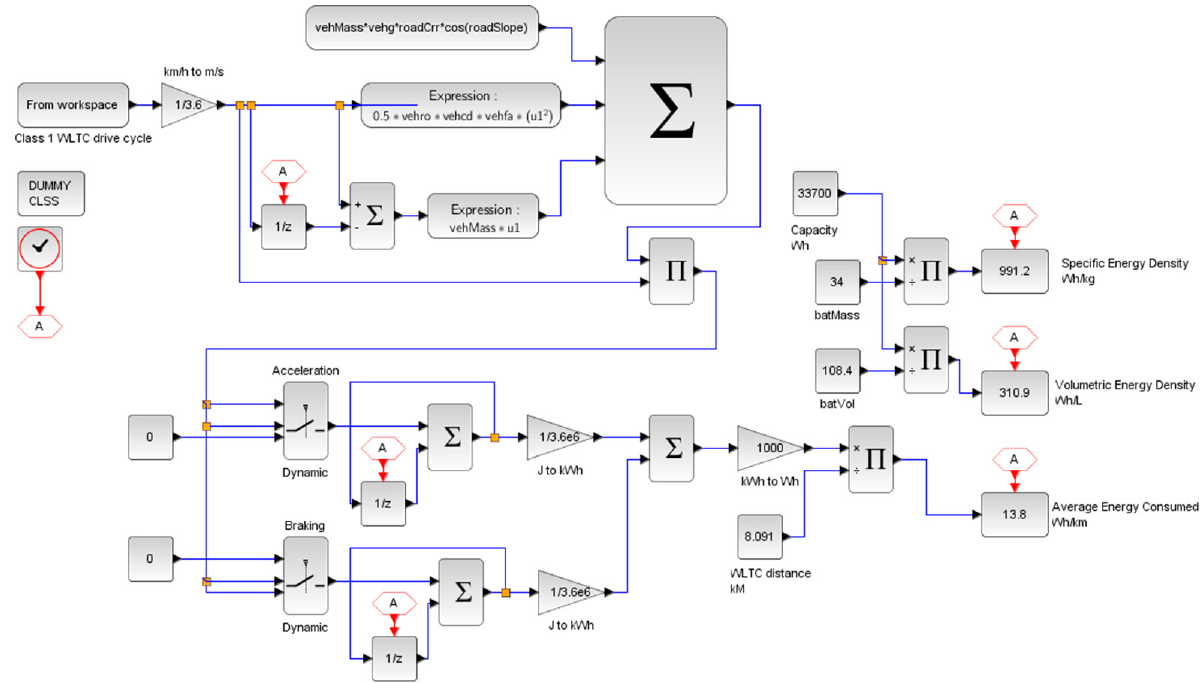
Figure 13. Scilab ® simulation diagram.